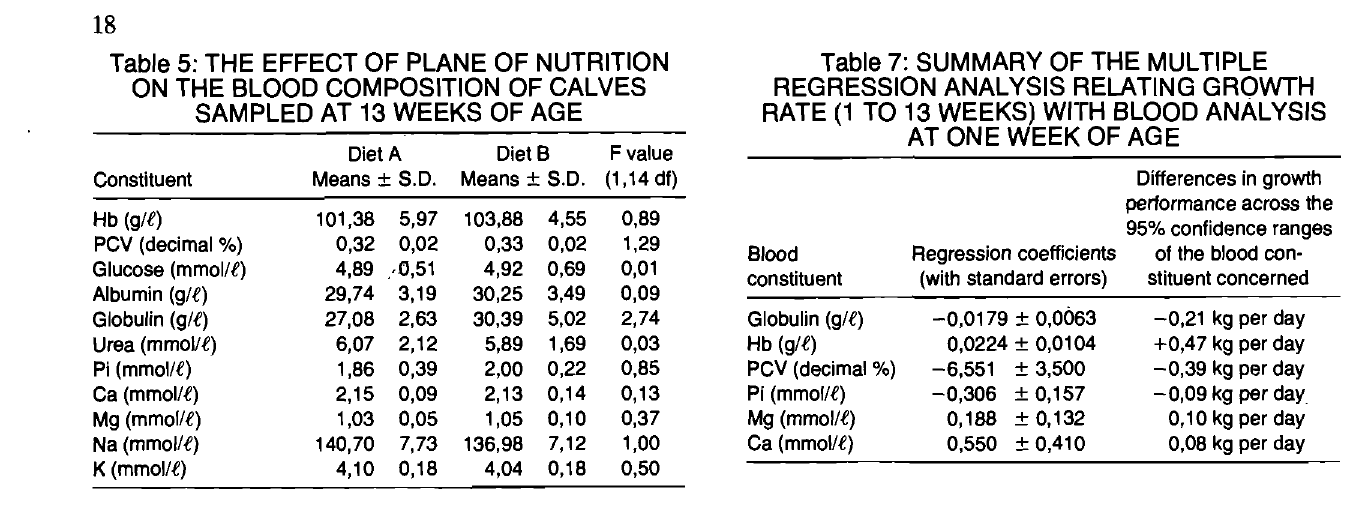
calves, were 12 g/e for globulin, 21 g/e for Hb, 6% for